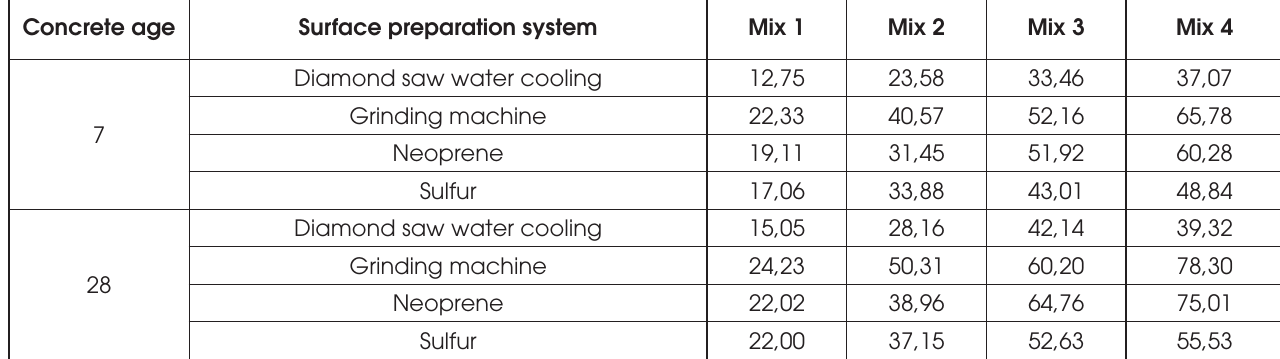
Average strengths for each surface preparation system and each mix of concrete at the ages of 7 e 28 days Concrete